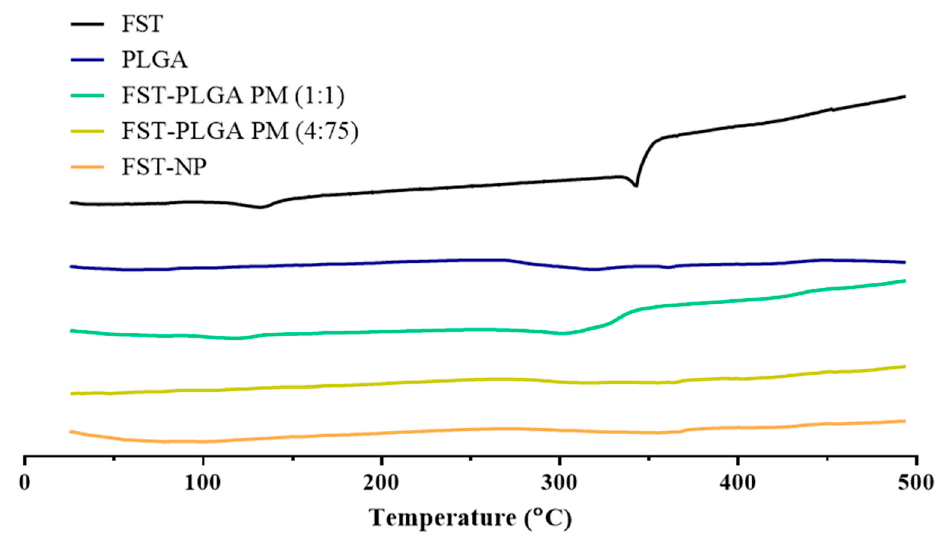
Figure 5. DSC thermogram of FST, blank PLGA nanoparticles, physical mixture 1:1, physical mixture 4:75, and FST–NP.